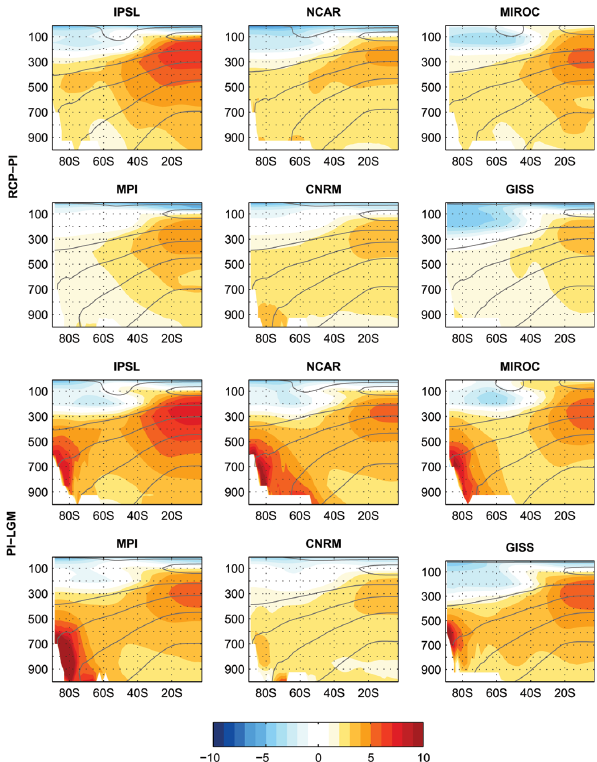
Fig. 7. Contribution to ( a × δT pole + b × δT trop ) for each model, for PI–LGM and RCP–PI: in red a × δT trop , in blue b × δT pole